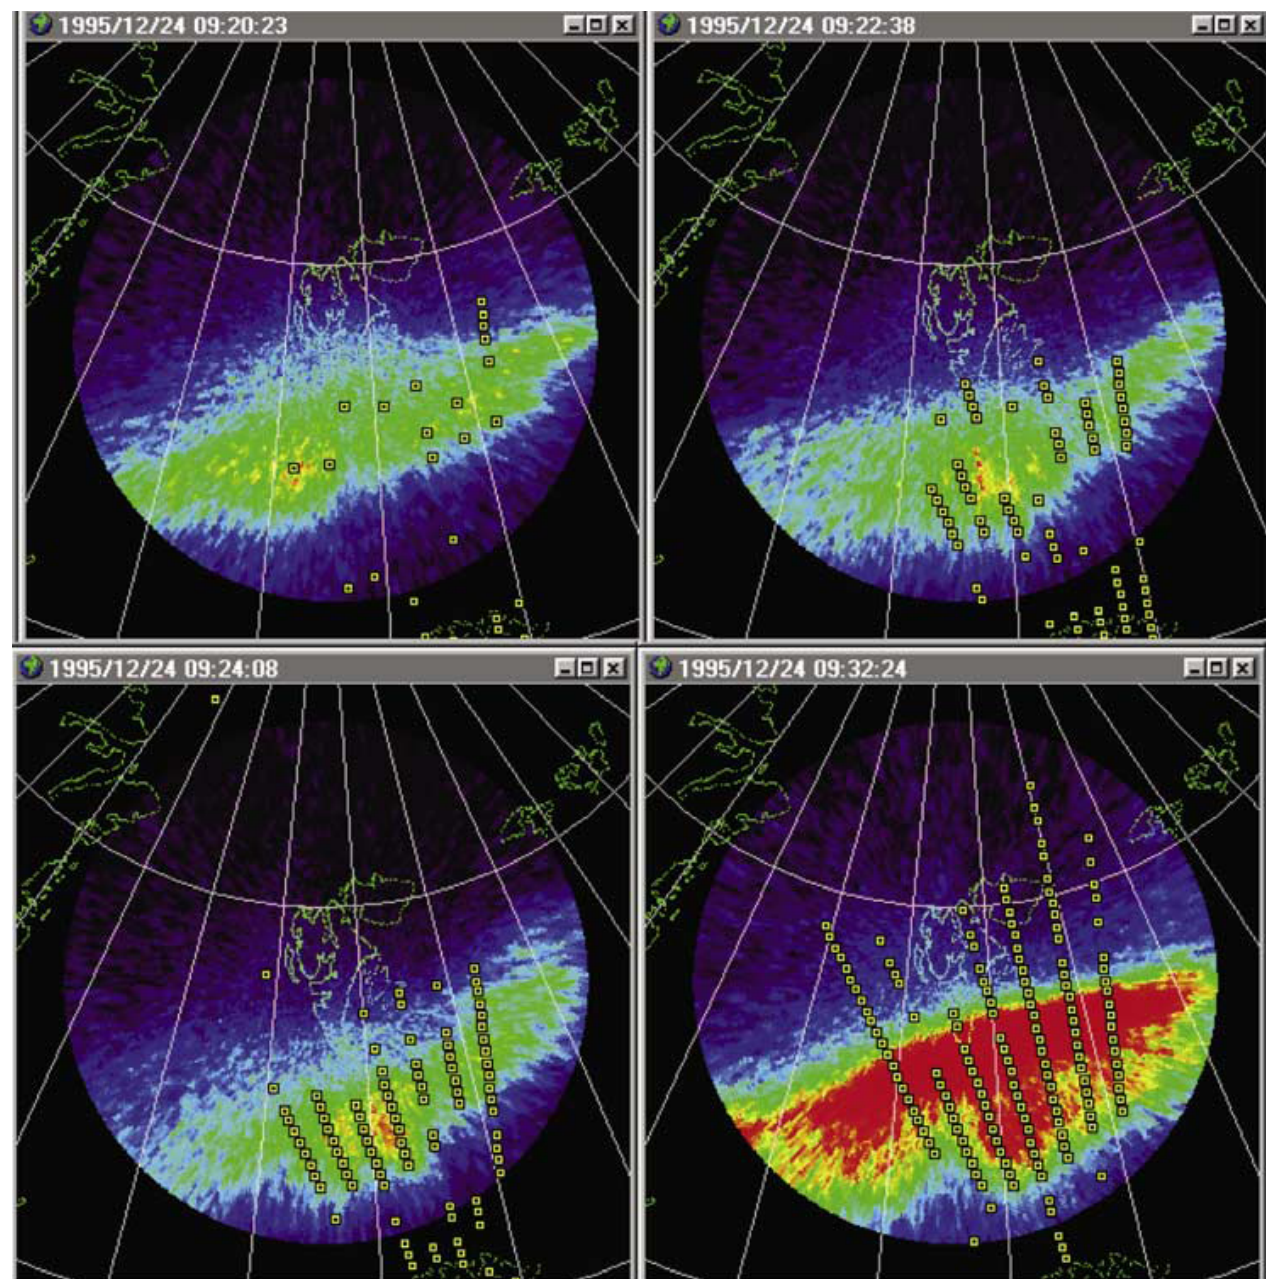
Fig. 7. Overlay of SuperDARN radar echoes on ASIP observations of the cusp over Svalbard. The onset of SuperDARN echoes coincides with the onset time for a brightening of the cusp aurora, interpreted in other studies as a signature of the onset of magnetopause reconnection events. The first three images show a very rapid onset (in two minutes) of SuperDARN echoes from newly formed plasma structures with size similar to the radar wavelength. The fourth frame shows that the initial spatial coincidence, of the equatorward edge of the radar echoes with that of the cusp aurora, still persists 10min after onset (adopted from Moen et al., 2001).